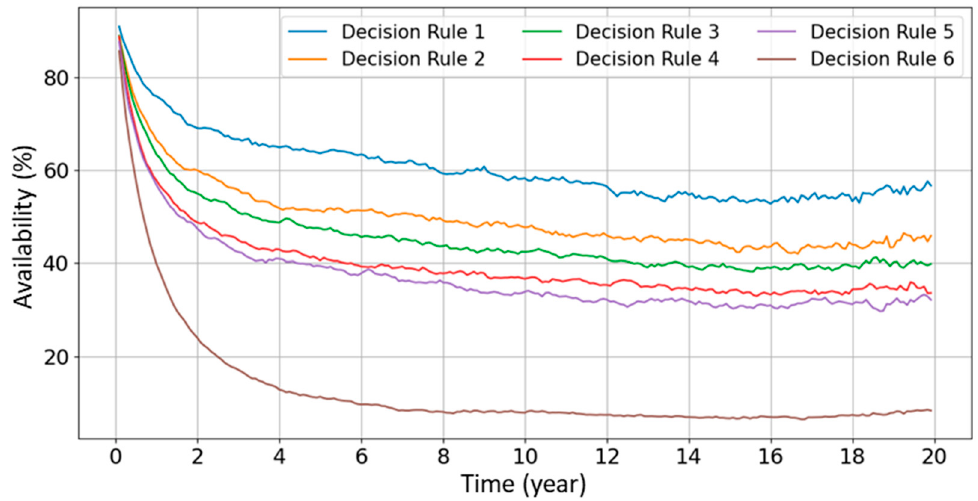
Figure 11. Comparison of availability for different Decision rules.